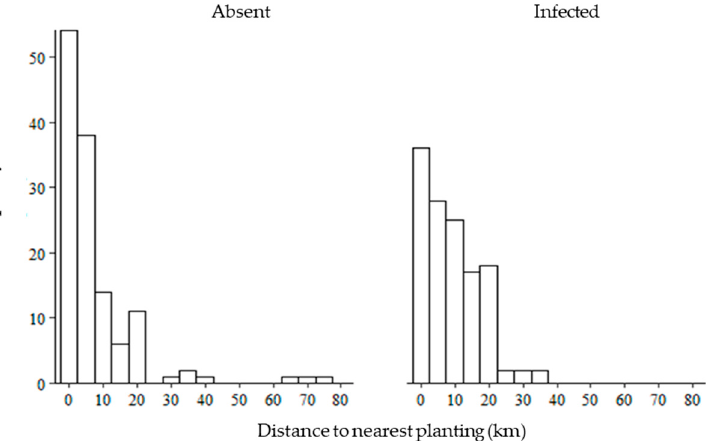
Figure 3. Comparison of distances (km) calculated between 130, 1 km resolution grid cells where P. austrocedri was apparently absent, and the same number of infected cells, to the nearest 2 km resolution planting event conducted before the date visited. Cells treated as “absent” were either visited 2012–2019 and showed no symptoms or sample material tested negative, and were drawn only from 2 km tetrads with no disease detections; infected cells contained a positive P. austrocedri detection (see Section